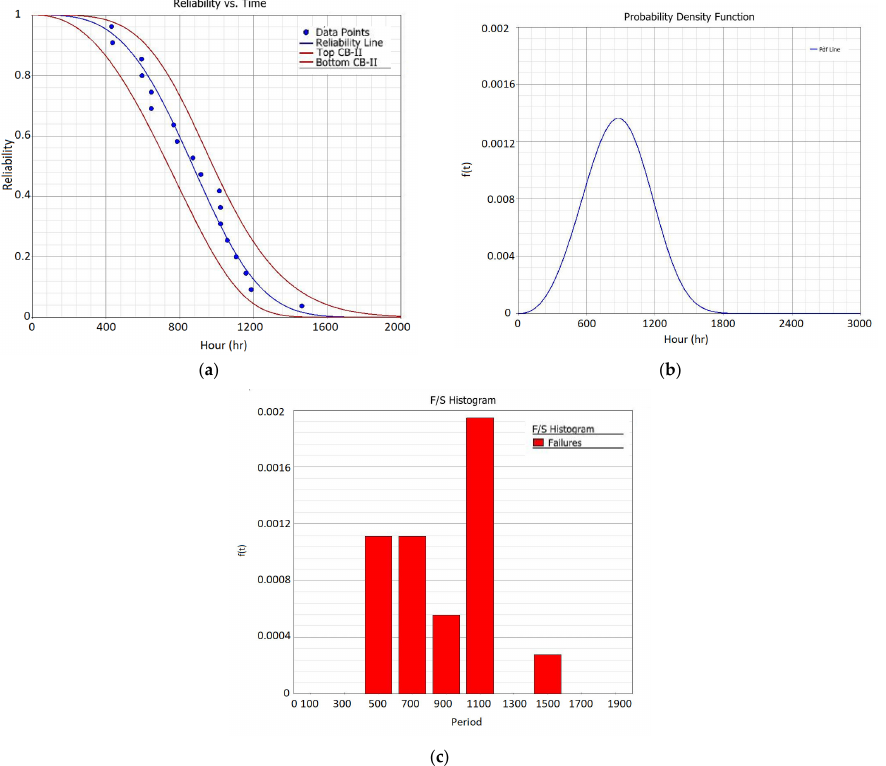
Figure 6. ( a ) Reliability function, ( b ) probability density function, ( c ) histogram for Unit 1. Appl. Sci. 2023 , 13 , x FOR PEER REVIEW